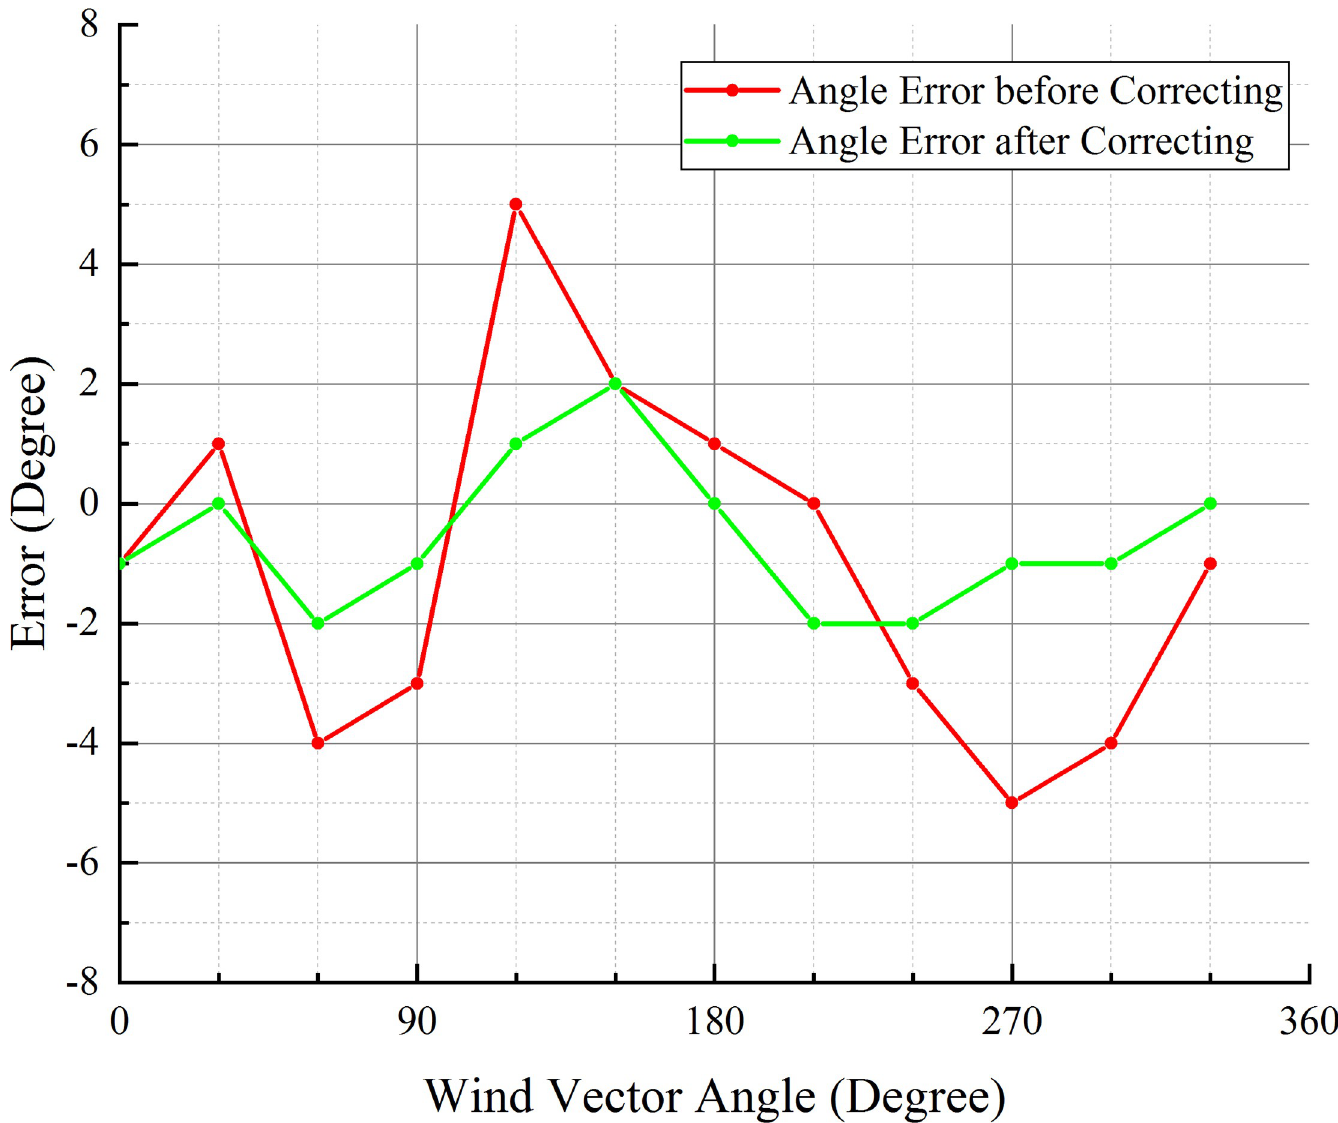
Fig 17. Comparison of the error distributions of the two wind angle measurement methods.